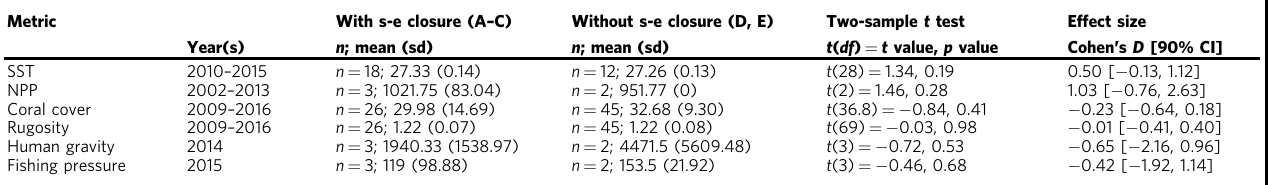
Valuesreportedre fl ectsummarystatisticsacrosscoralreefsiteswithandwithoutsigni fi cantsocial – ecological(s-e)networkclosureeffects,aswellasresultsfromatwo-sided,two-sample t testoftheir mean difference and estimated effect sizes. Rugosity is a measure of structural complexity; human gravity is a measure of human impacts that accounts for human population size and reef accessibility 49 . Benthic data to calculate coral cover and rugosity was unavailable in site A, thus “ With s-e closure ” for these metrics report means from sites B and C. Supplementary Table 7